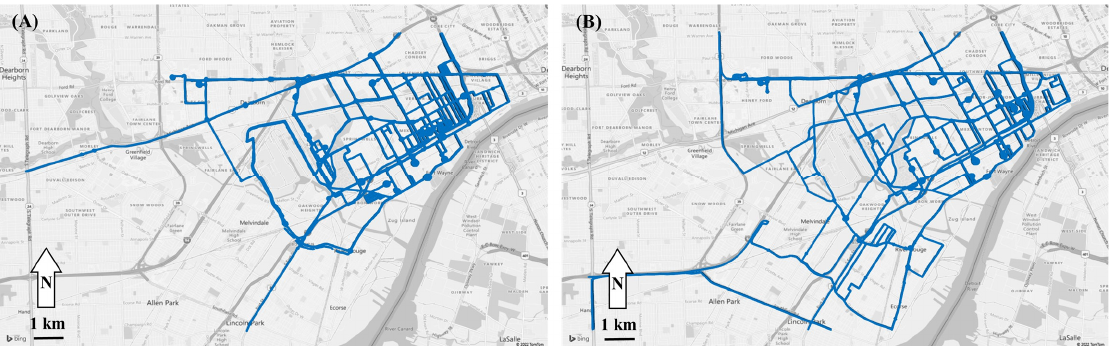
Figure 2. Maps showing driving routes for data subsets 1 ( A ) and 2 ( B ). Maps represent a 11 × 17 km region. Often, repeated passes were made both within and among the days in the 10-day data subsets. Solid circles represent periods when the vehicle was parked for an extended period (typically more than 0.5 min).